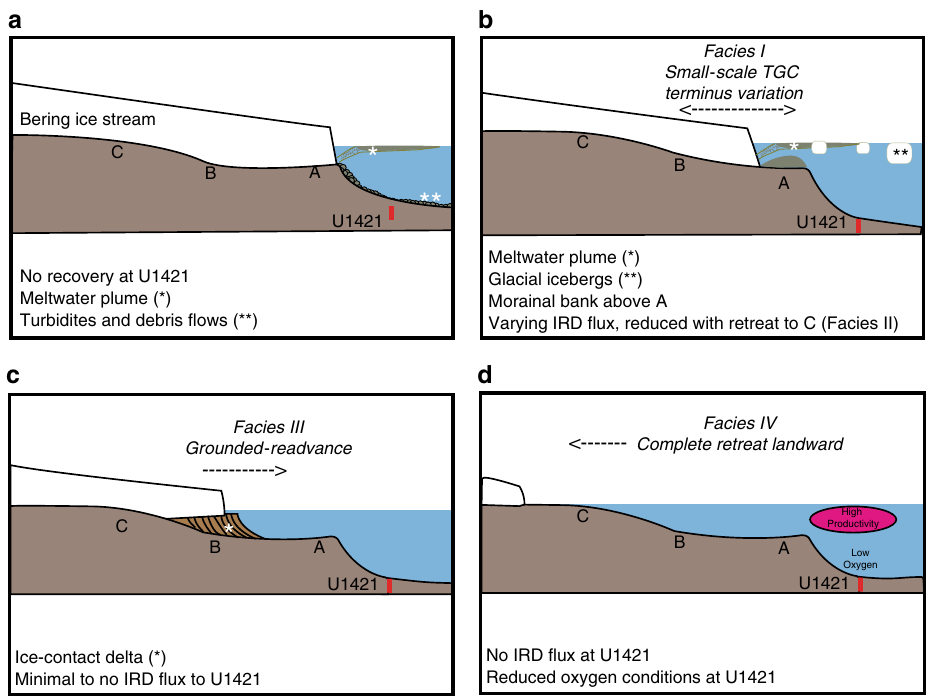
Fig. 4 Bering ice stream terminus position. Cartoons showing BIS terminus position within the trough at positions A – C identi fi ed on seismic pro fi le in Fig. 3b and paleoenvironmental conditions recorded by sedimentary facies on the continental slope at Site U1421. a Maximum advance with terminus at shelf edge. b Terminus fl uctuates between A and B. c Terminus readvance from C to A with formation of ice-contact delta fi lling inner shelf basin. d Complete retreat with terminus landward of